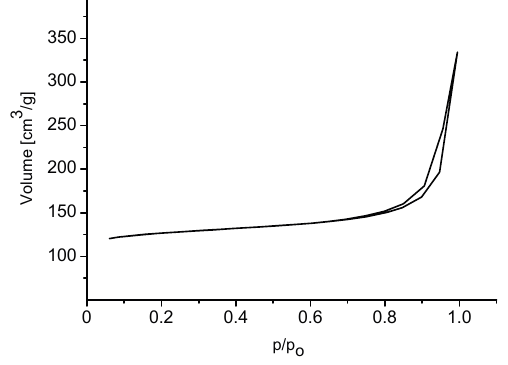
Figure 6. Adsorption/desorption isotherms of nitrogen on the MCM-22